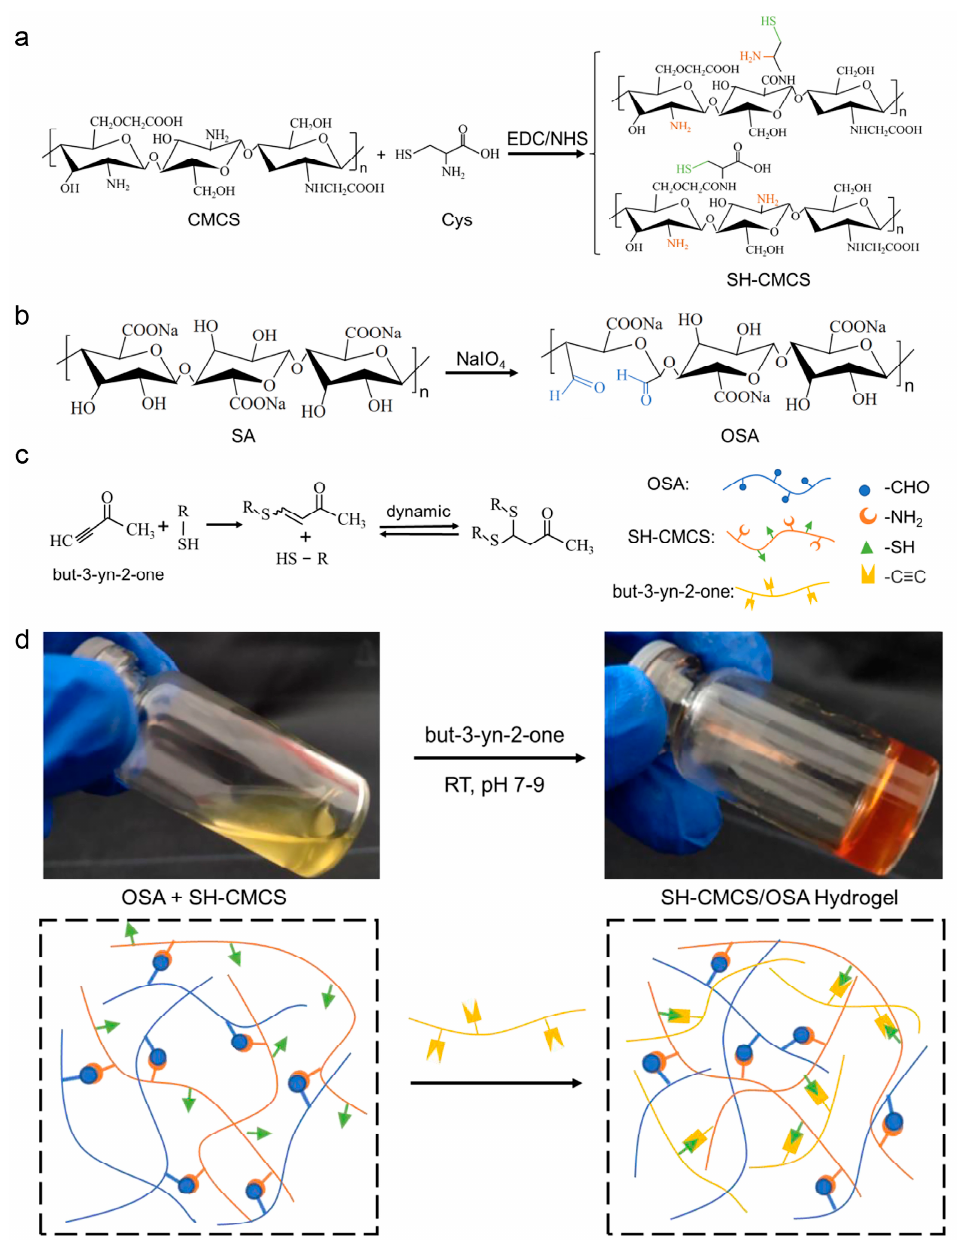
Figure 1. ( a ) OSA synthetic route; ( b ) CMCS graft Cys synthesis route; ( c ) Dynamic thiol-alkynone double addition; ( d ) SH-CMCS/OSA hydrogel-forming gels.